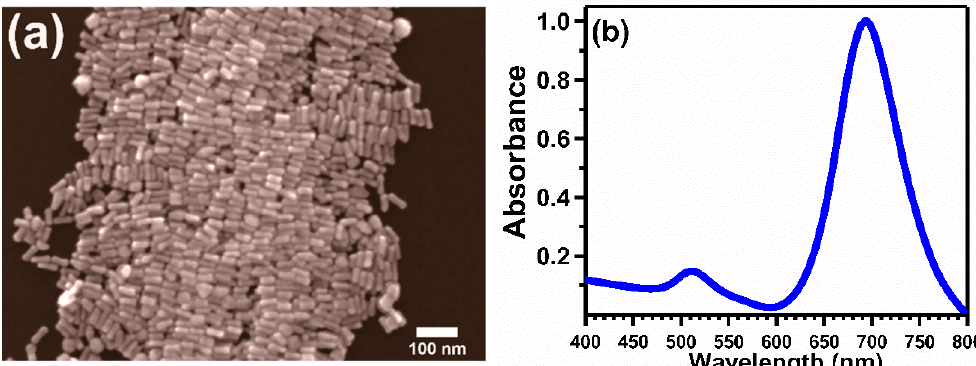
Figure 1. CTAB (Cetyl trimethylammonium Bromide)—assisted short anisotropic gold nanorods (AuNRs) synthesized by a two-step seed-mediated approach (( a ), scale bar: 100 nm). The optical absorbance spectra from the as-synthesized short AuNRs display two plasmon bands corresponding to the transverse and longitudinal mode of conduction electron oscillations ( b ).